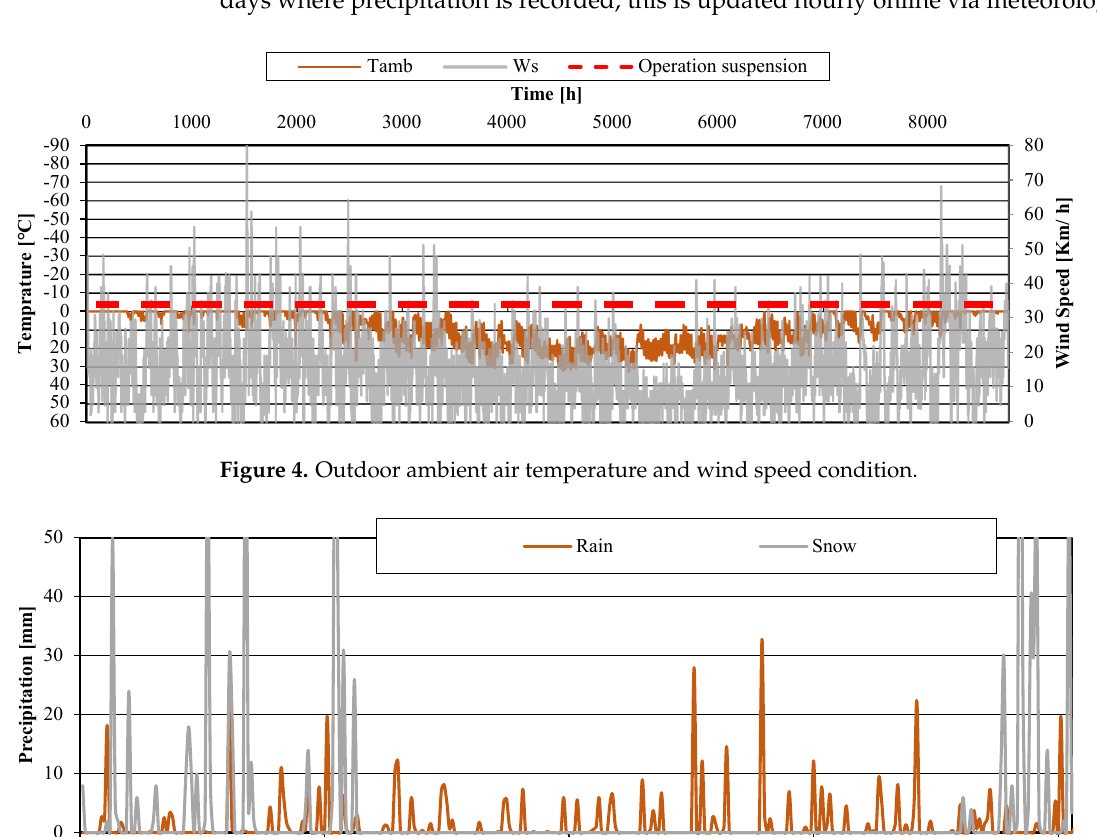
Figure 3. 3D digital-twin showing a zoom in on the Toronto city hall.